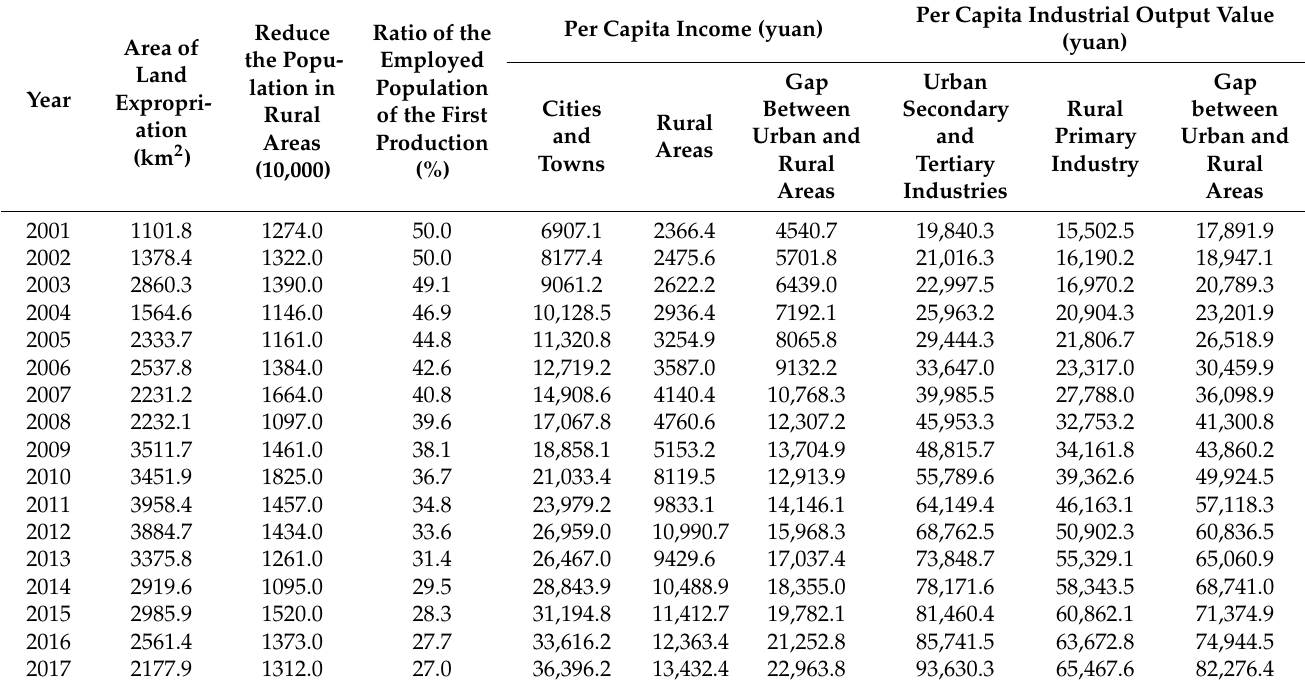
Table 5. The gap between the area of land expropriation and the rural employed population and the per capita output value of urban and rural